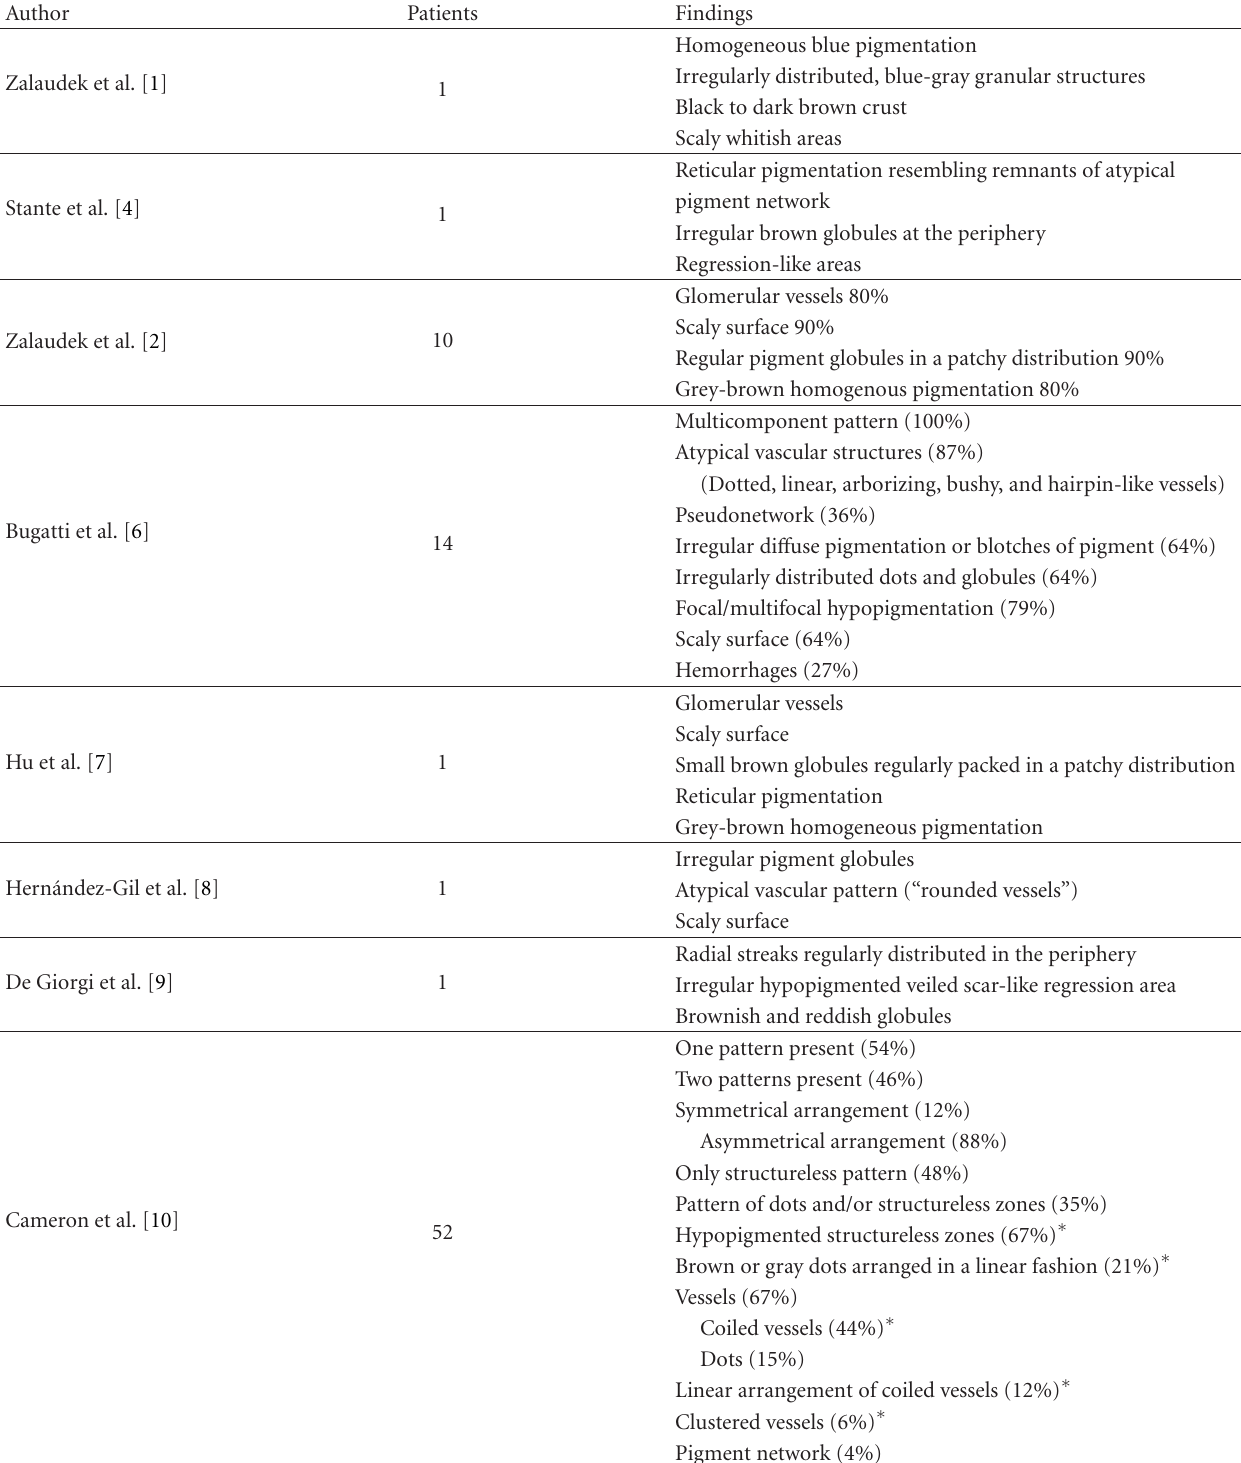
Table 1: Dermoscopic features of pigmented Bowen’s disease from various